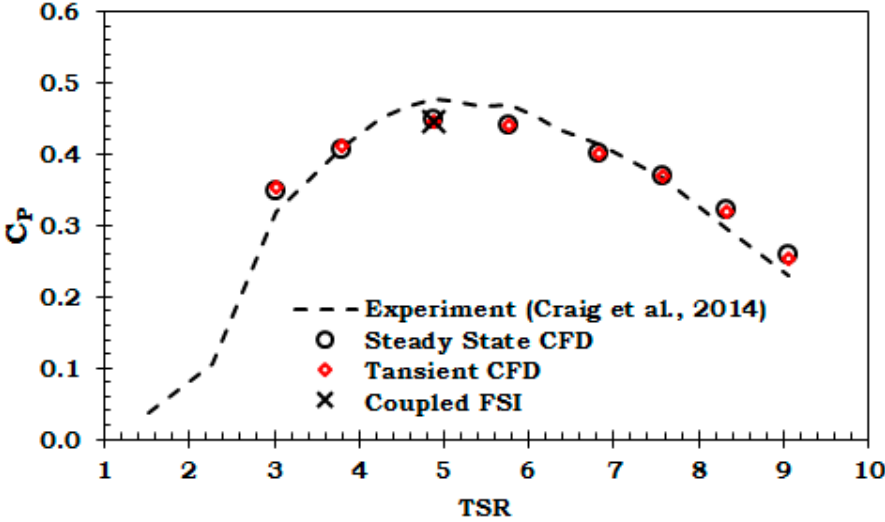
Figure 5. Comparison of experimental and simulated performance curves. Table 3. Quantitative comparison of turbine C P between simulations and experiment.